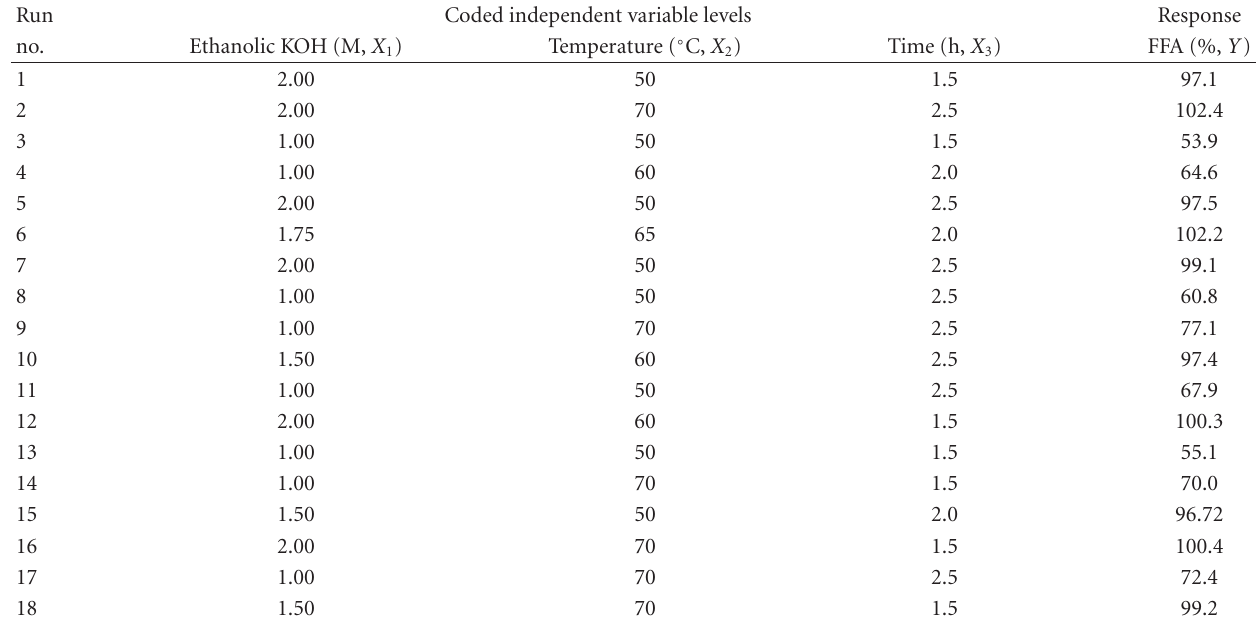
Table 2: D-optimal design optimization of J. curcas seed oil saponification and response for FFA%.